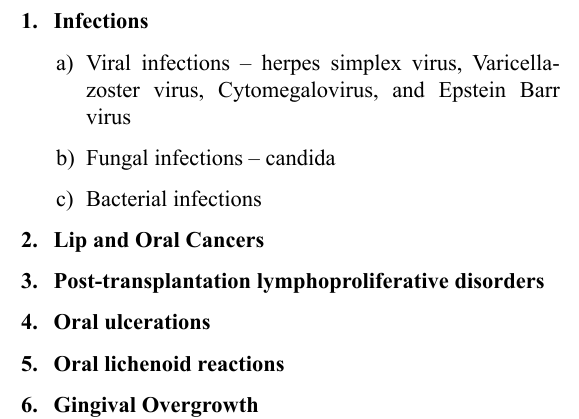
Table 2: Oral cavity lesions seen in kidney transplant recipient